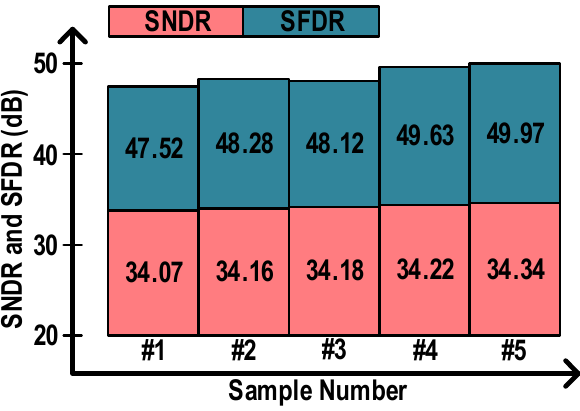
Figure 12. Measured SNDR and SFDR from five different samples near Nyquist input at 700 MS/s. Figure 13 shows the fast Fourier transform (FFT) results of the minimum (Figure 13a: Sample #1) and maximum (Figure 13b: Sample #5) SNDR among the five samples shown in Figure 12. As shown in Figure 13a, the minimum SNDR and SFDR were 34.07 dB and 47.52 dB, respectively, and the effective number of bits (ENOB) was 5.36 bits even without comparator offset calibration.